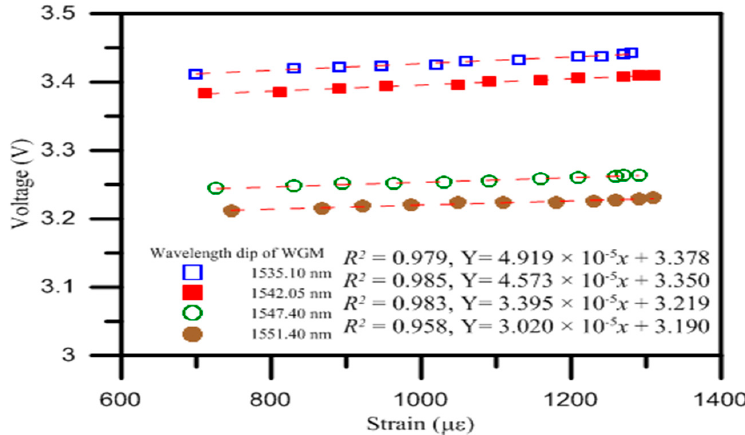
Figure 7. The relationships between the voltage signals of the intensity modulation system and the signals of the strain gauge.